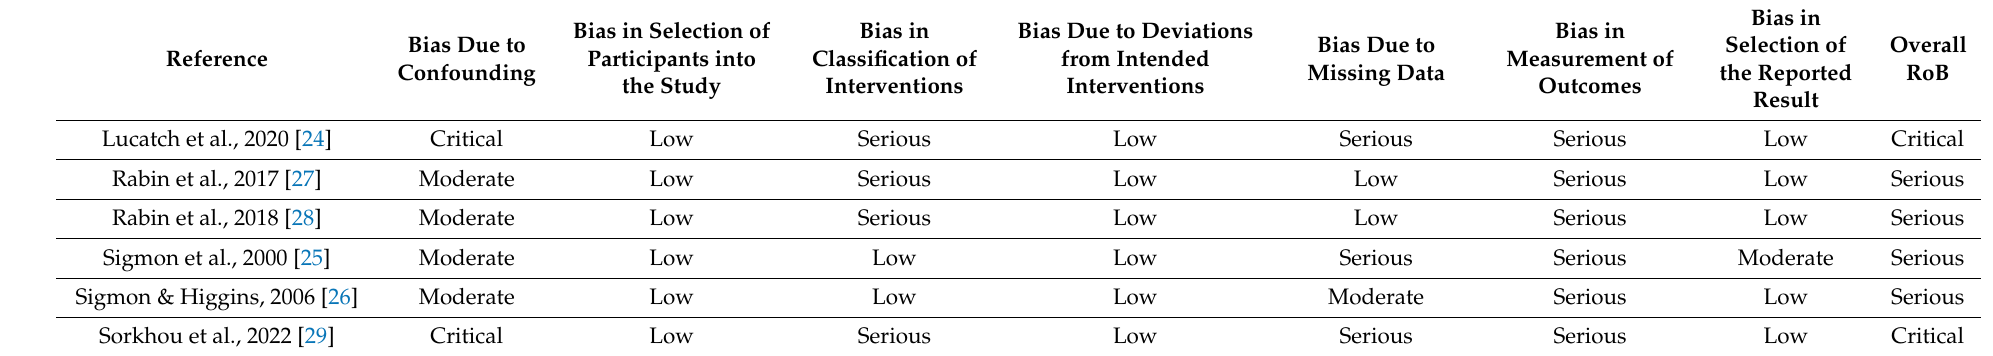
Table 2. Risk of Bias Using Cochrane’s Risk of Bias In Non-randomized Studies—of Interventions (ROBINS-I)